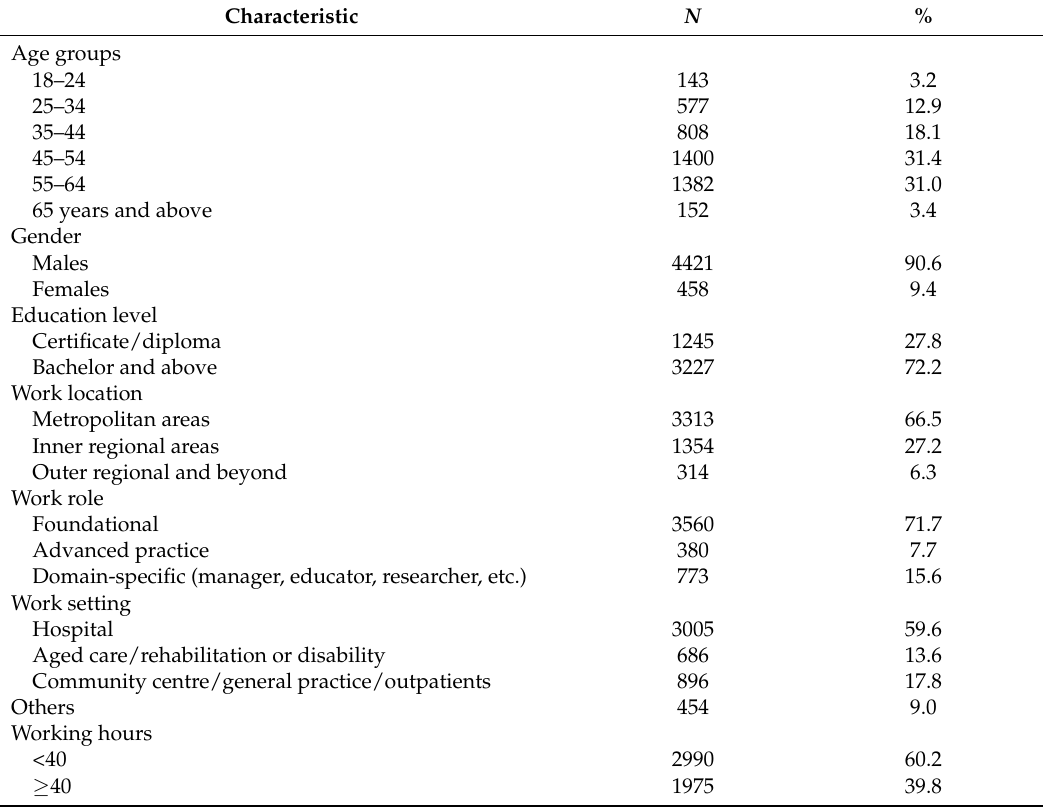
Table 1. Socio-demographic characteristics of nurses and midwives ( N =